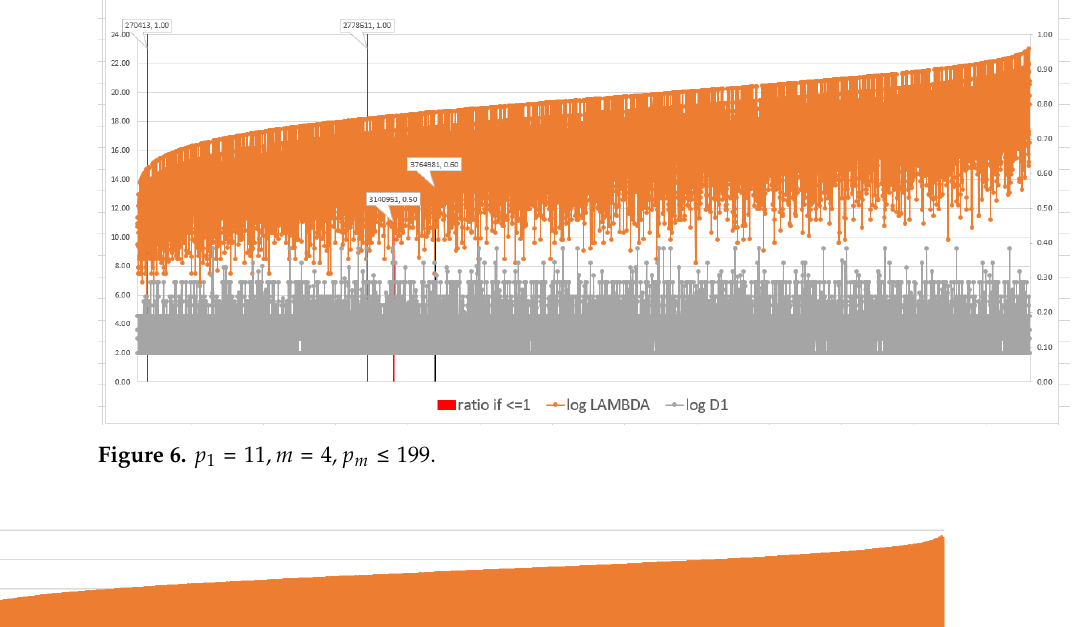
Figure 6. p 1 = 11, m = 4, p m ≤ 199.